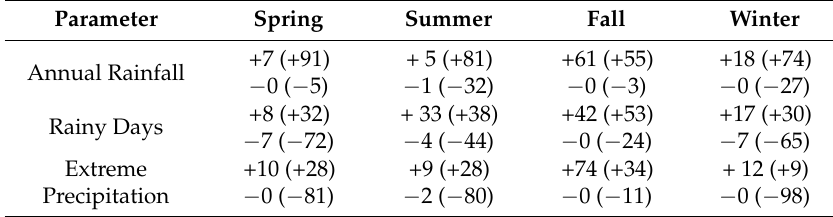
Table 1. Trend statistics for the seasonal precipitation parameters. (‘+’ sign indicates a positive trend and ‘ − ’ sign indicates a negative trend. Values outside of the parenthesis (and in boldface) indicate the number of stations with a significant trend and values inside the parenthesis indicate the number of stations without a significant trend).